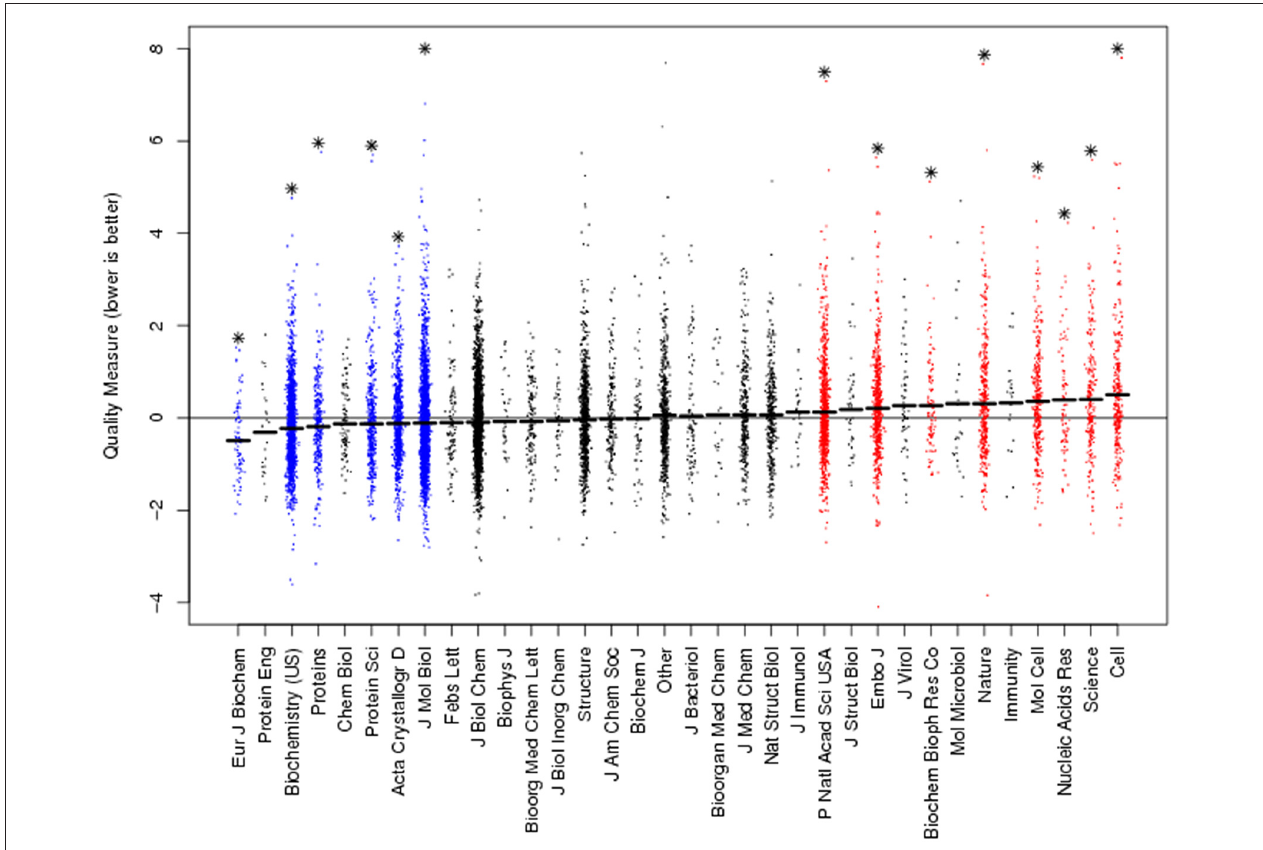
FIGURE 1 | Ranking journals according to crystallographic quality reveals high-ranking journals with the lowest quality work. The quality metric ( y -axis) is computed as a deviation from perfect. Hence, lower values denote higher quality work. Each dot denotes a single structure. The quality metric was normalized to the sample average and journals ranked according to their mean quality. Asterisks denote significant difference from sample average. Figure courtesy of Dr. Ramaswamy, methods in Brown and Ramaswamy